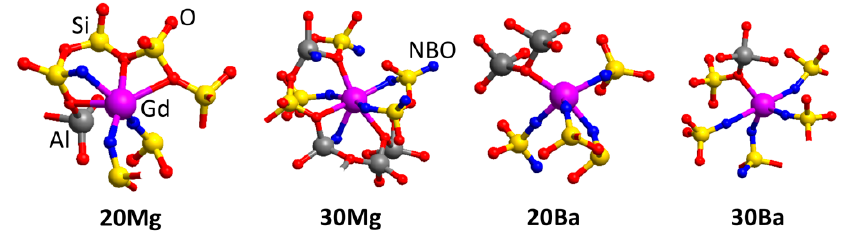
Figure 4. Examples for structural models of the first and second coordination shell of Gd 3+ ions. Non-bridging oxygens (NBO) are highlighted in blue.